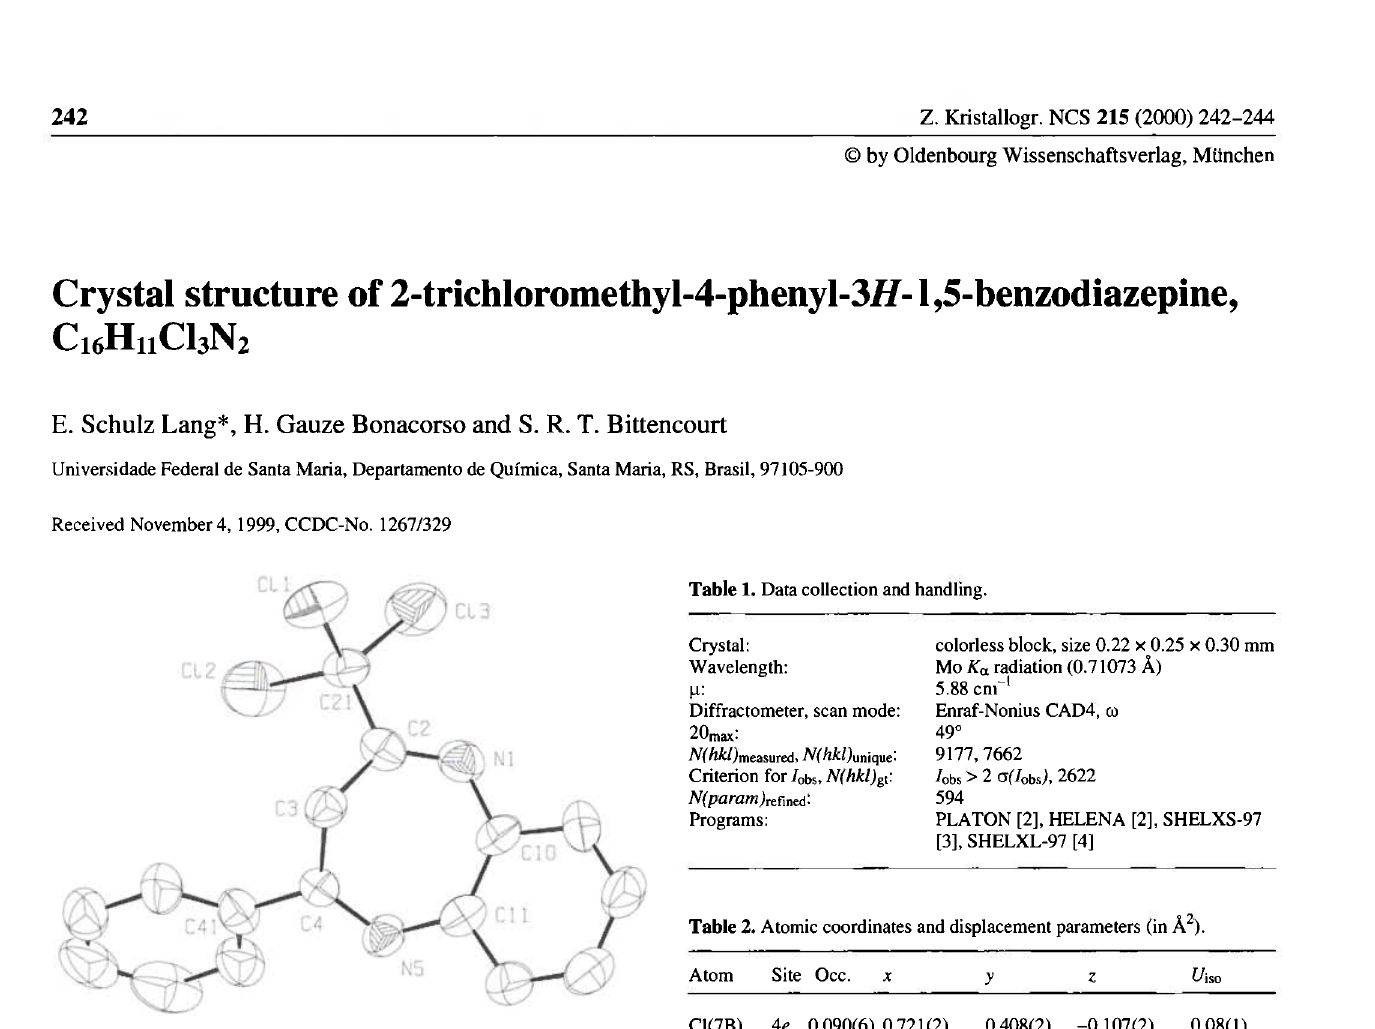
Table 2. Atomic coordinates and displacement parameters (in Ä 2